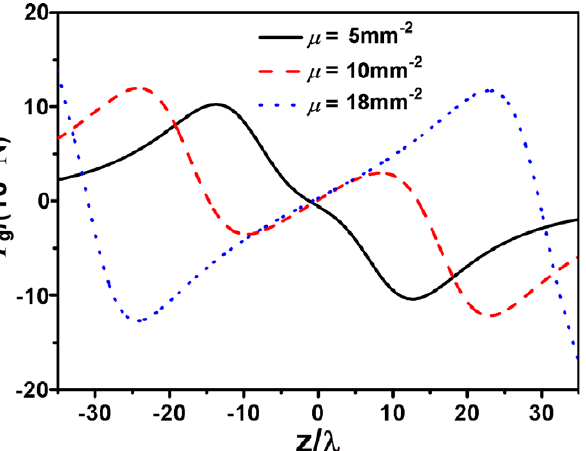
Figure 7. Influence of cross-phase modulation on the gradient force along the optical axis. Parameters for calculation are chosen as λ = 633 nm, α = 3, NA = 0.9, f = 3.4 cm, n 2 = 1.5, n 1 = 1.3, and a = 20 nm, (cid:112) E 0 = 100 ( mW/um 2 )